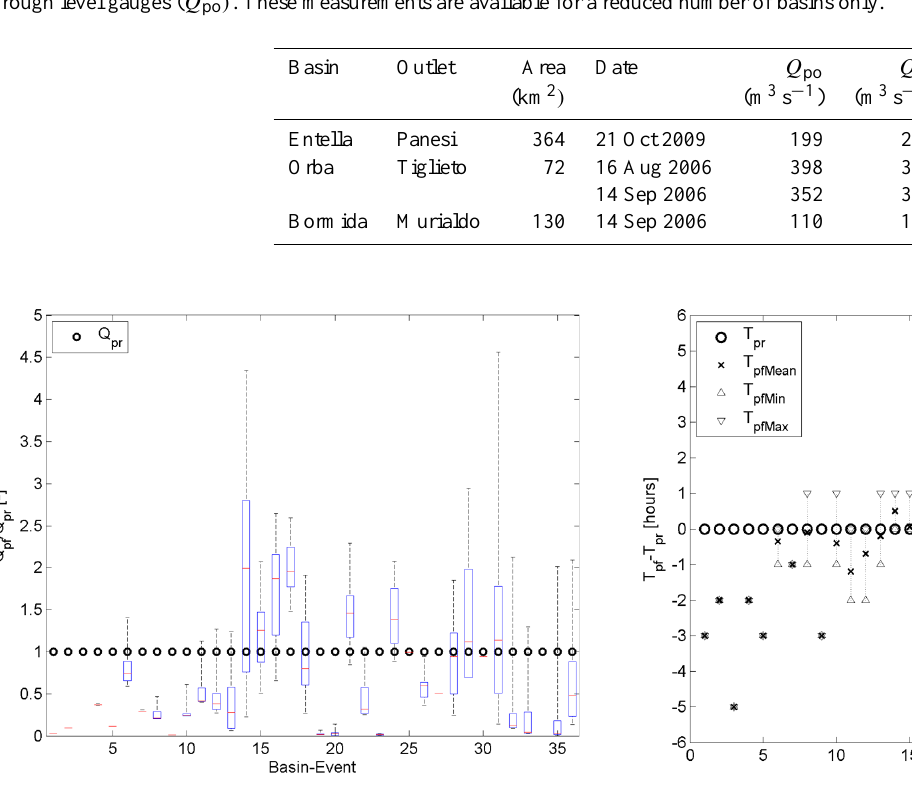
Fig. 9. Results of hydrological nowcasting framework for basin with area ≤ 150km 2 in terms of time of the peak flow. The dots are the reference hydrograph peak time, the triangles are the maximum and the minimum peak times of the discharge ensemble, the x is the mean of the peak times of the discharge